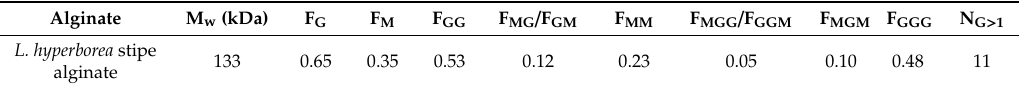
Table 3. Chemical characterization of the starting material used for chemical modification and as unmodified alginate in alginate hydrogels. Composition is described by the fraction of M and G (F M and F G ), fraction of diad and triplet sequences (e.g., F GGG : fraction of alginate consisting of guluronic triplets) and the average length of G-blocks (N G > 1